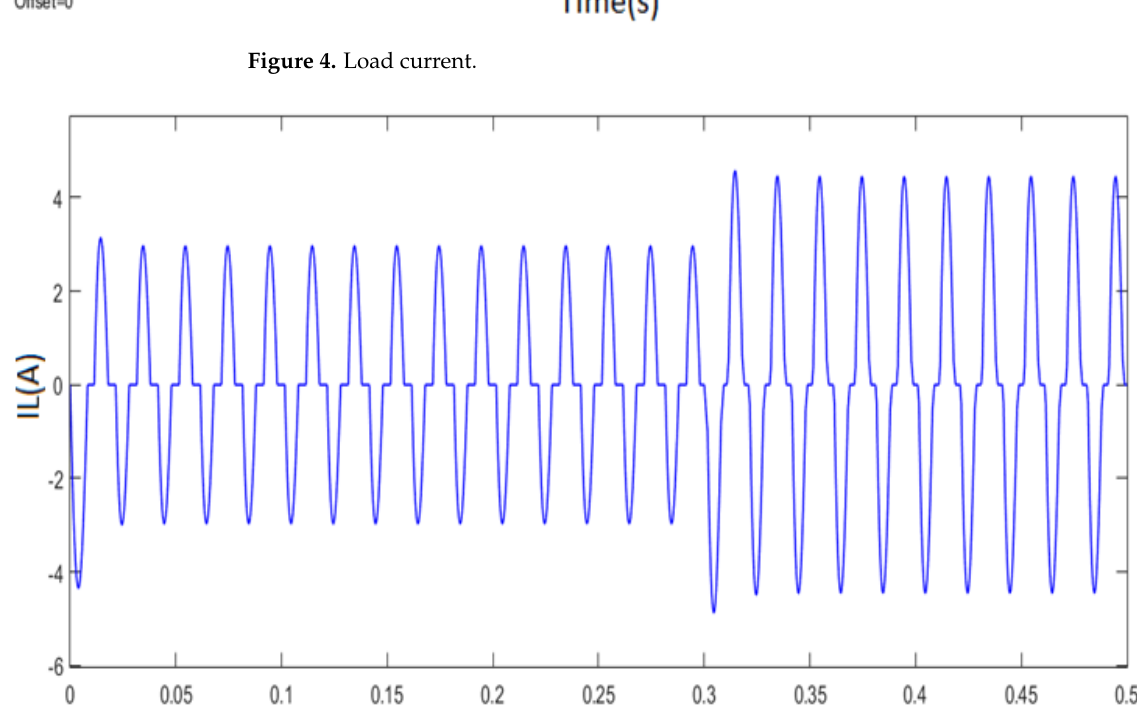
Figure 4. Load current.